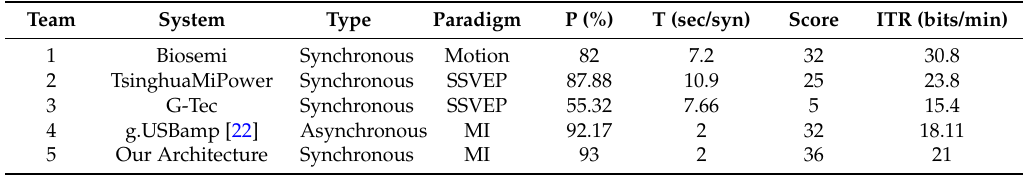
Table 11. ITR comparison of different application in BCI competition [40].